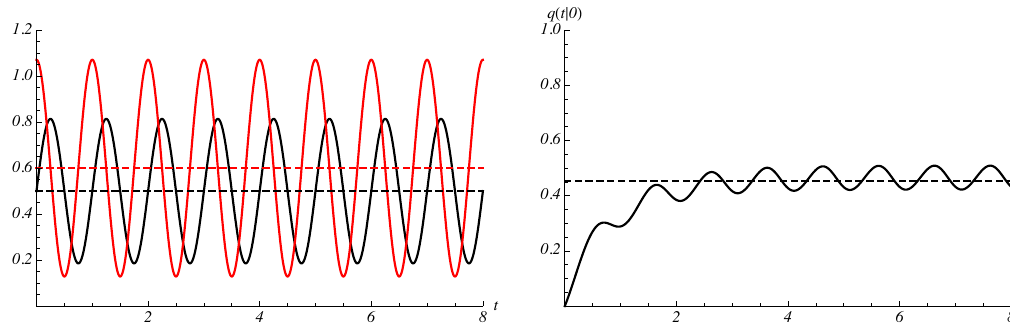
Figure 3. On the left: the periodic catastrophe intensity function (black curve) and repair intensity function (red curve), with their averages (dashed lines). On the right: the failure probability q ( t | t 0 ) , given in (18), and the limit q ∗ (dashed line), given in (29). The parameters are specified in Example